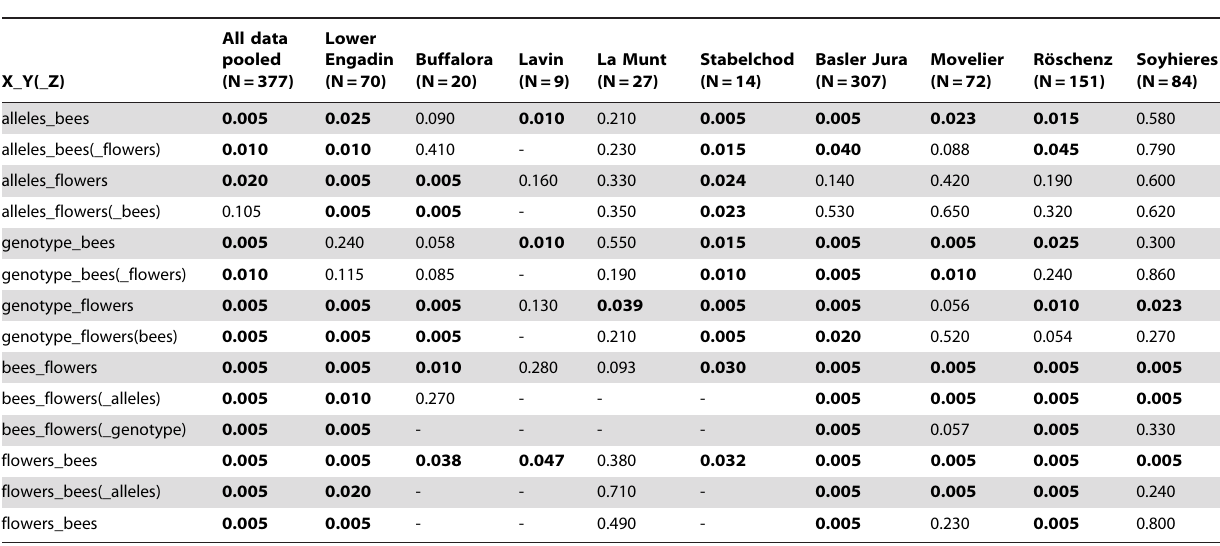
Table 3. Summary of redundancy